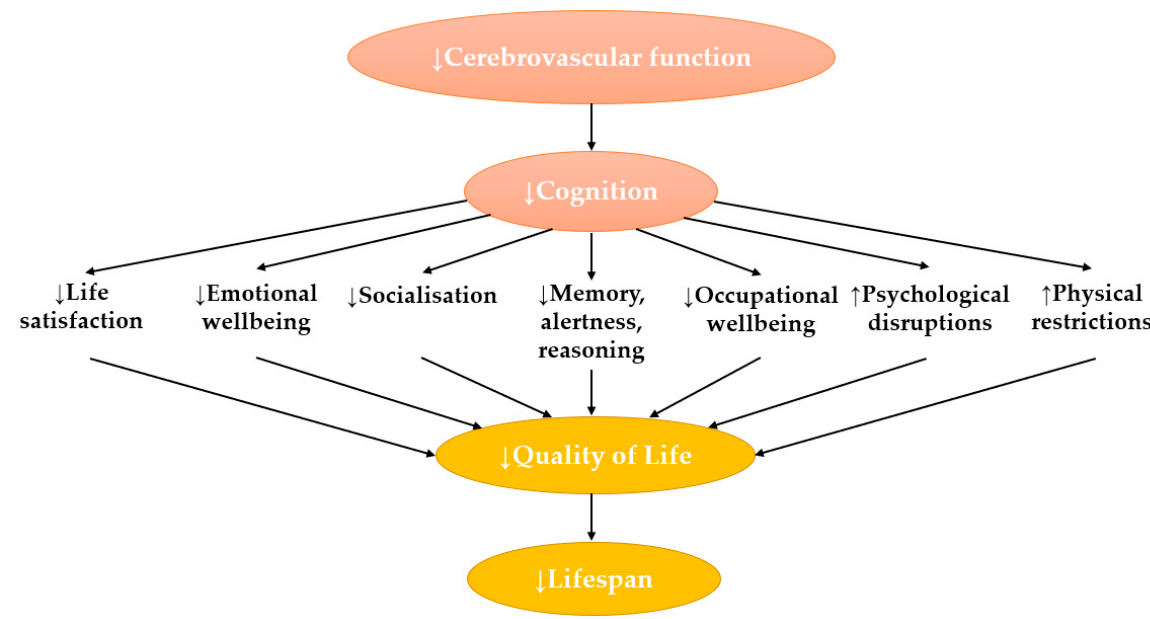
Figure 1. The outcomes of reduced cerebrovascular function leading to reduced quality of life. Lowered cerebrovascular function influences cerebral hypoperfusion, which causes structural and functional changes leading to reduced cognition. Reduction of cognition affects multiple regions of the brain, which influence aspects that contribute to quality of life. This includes psychological, physical, social, and occupational wellbeing. Lowered quality of life can reduce life expectancy [5].